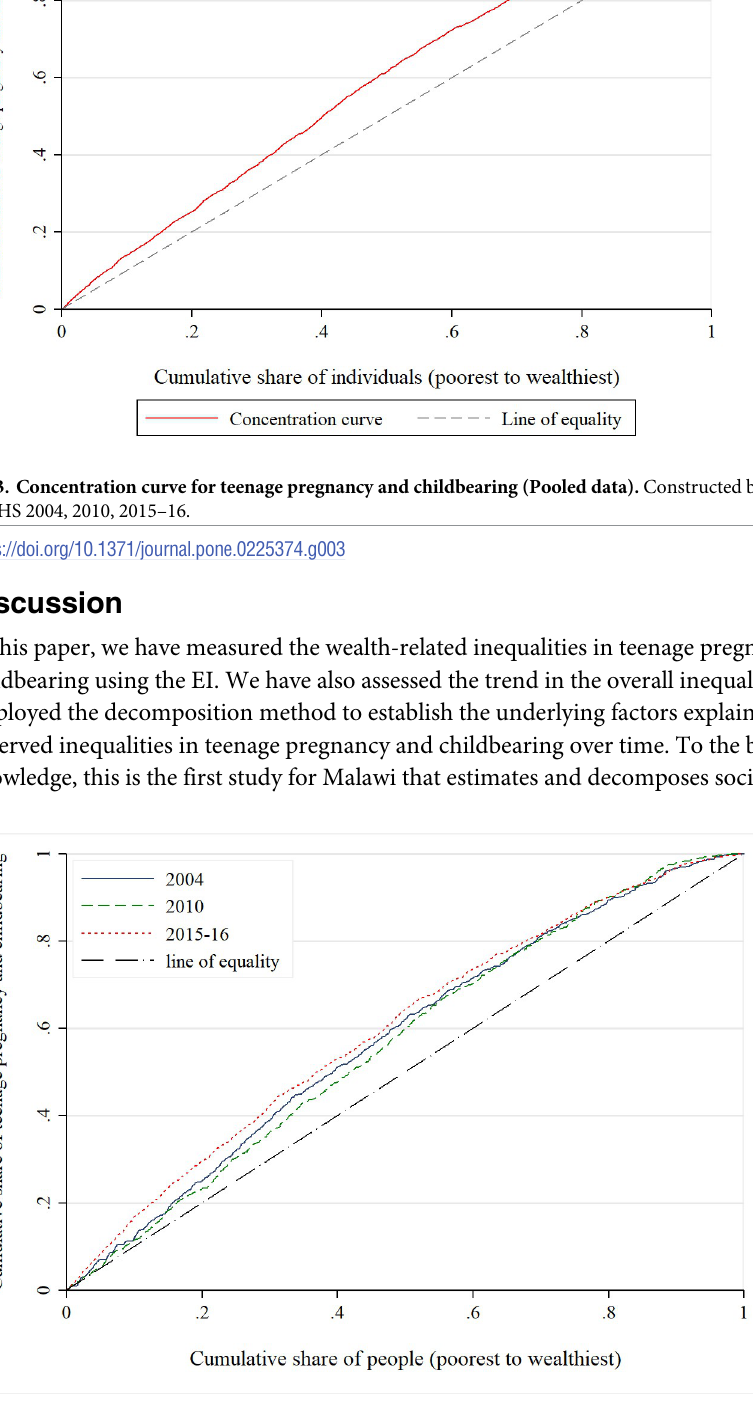
Fig 4. Concentration curve for teenage pregnancy and childbearing 2004–2016. Constructed by authors from MDHS 2004, 2010,